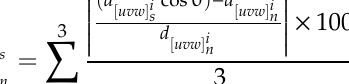
Figure 7. Processing maps of the MZCM at the strains of ( a ) 0.1, ( b ) 0.3, ( c ) 0.5 and ( d ) 0.7.